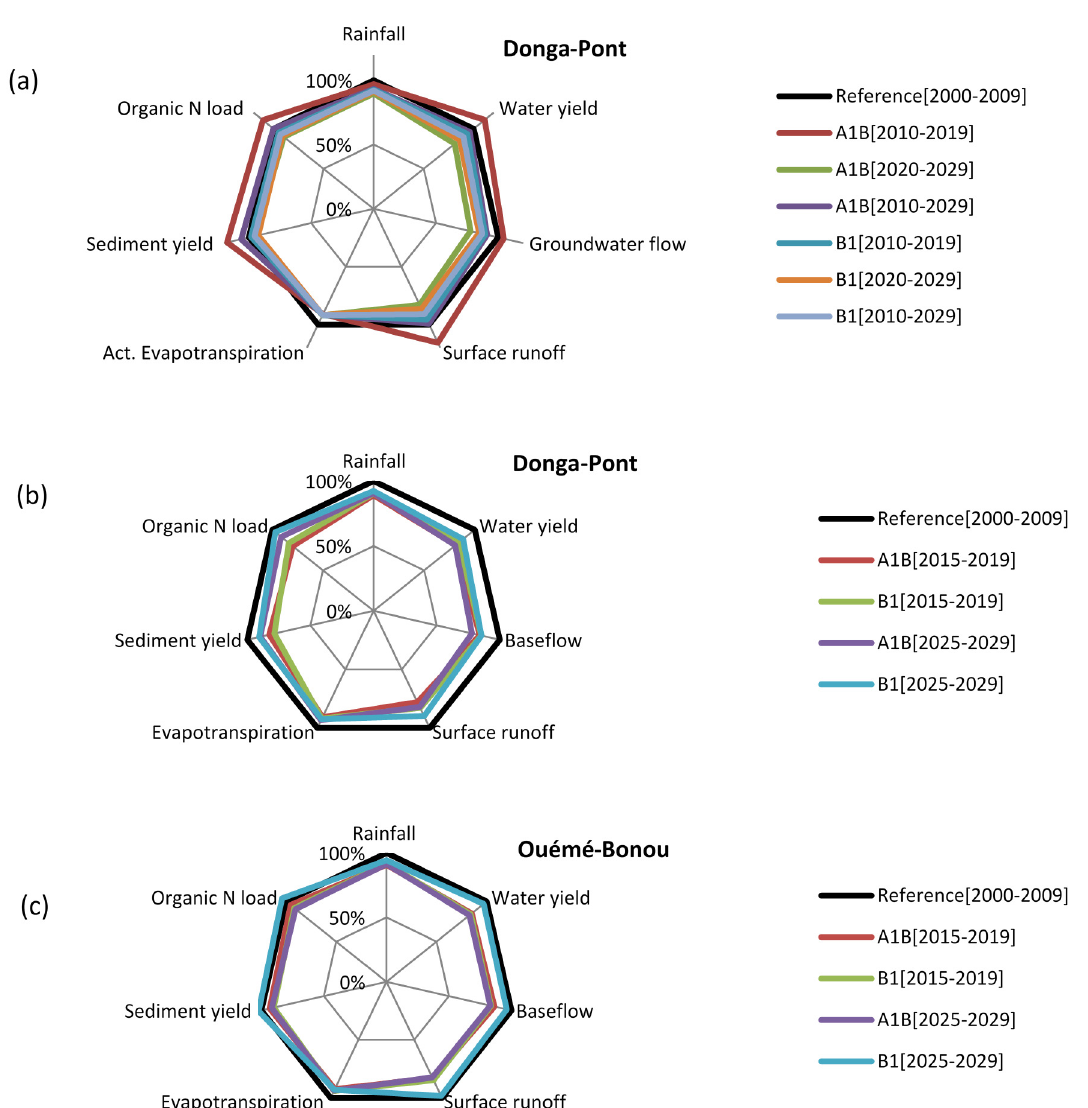
Figure 11. Simulated trends under climate scenarios with land use from the year 2003. ( a ) Donga-Pont: trend over 20 years; ( b ) Donga-Pont: trend over a 5-year time window; ( c ) Ouémé-Bonou: trend over a 5-year time window.